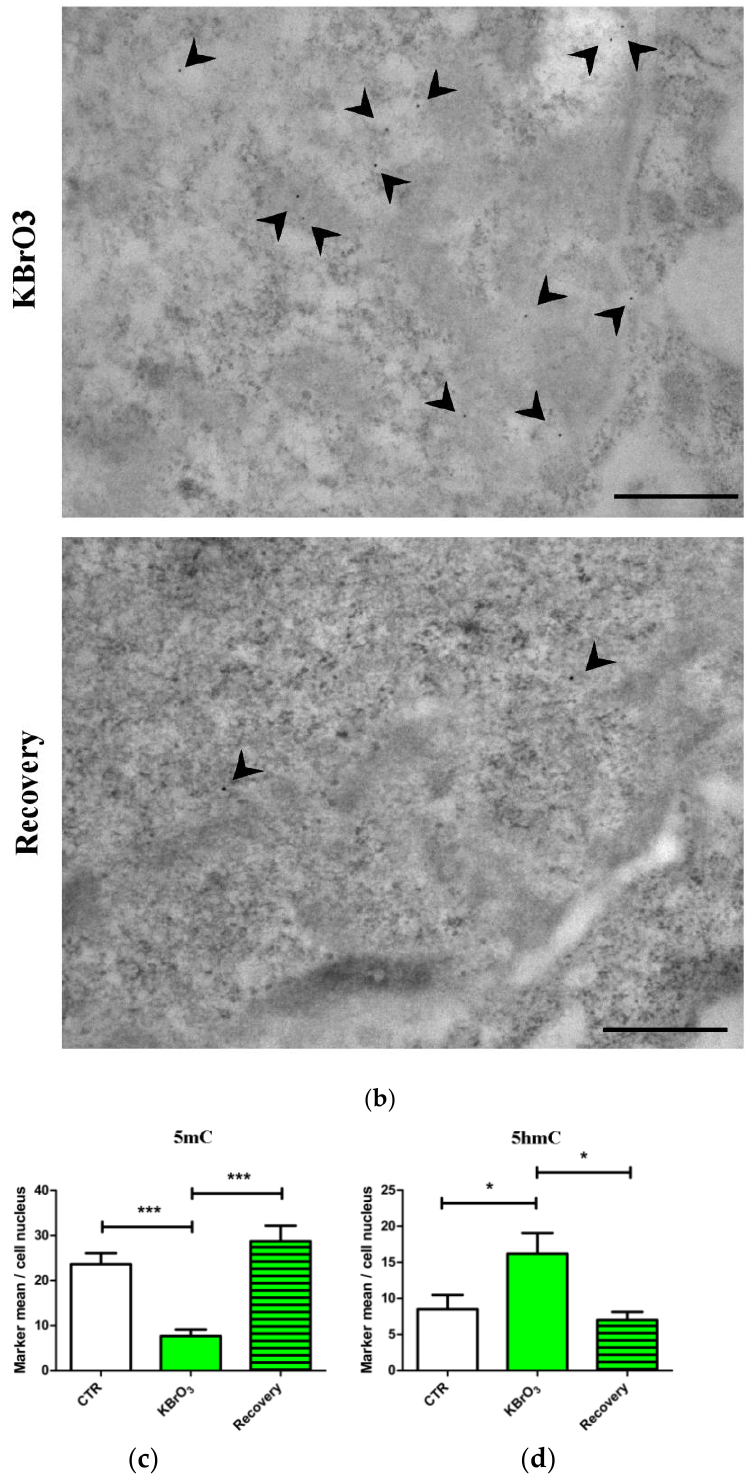
Figure 1. TEM micrograph showing ( a ) 5mC labelling (arrowheads) and ( b ) 5hmC labelling (arrowheads). Note 5mC localization in the EDTA-bleached heterochromatin and 5hmC main localization in the perichromatin region. Bars: 500 nm. ( c , d ) Histograms representing the abundancy of 5mC and 5hmC per nucleus. Asterisks identify colloidal gold counting-revealed significant differences. Mean with SEM are reported (*: p Value < 0.05; ***: p Value < 0.001).